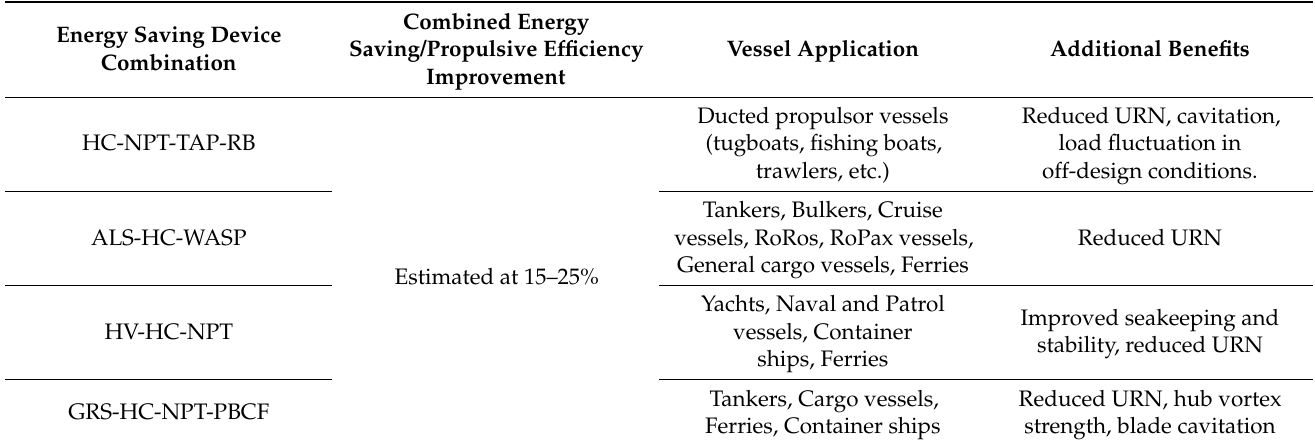
Table 4. Potential ESD combinations for specific vessel